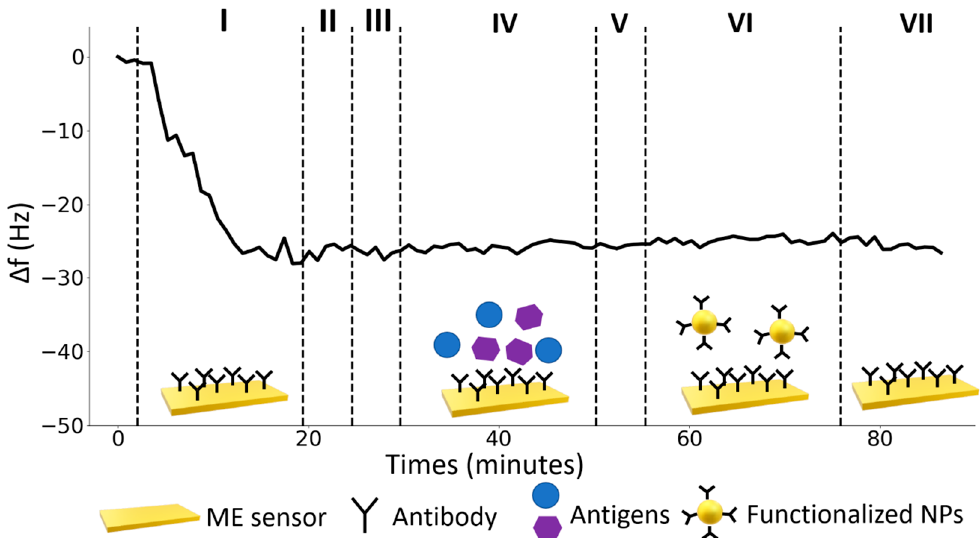
Figure 7. Sensor specificity. ME sensor responses to a mixed solution of rabbit IgG produced in sheep and mouse IgG produced in goat. The black line represents the response of the sensing ribbon in each of the following steps: (I) functionalization with a solution of 25 μ g ∙ mL − 1 of UV-activated antibodies, (II) rinse with MilliQ water, (III) flowing of bovine serum albumin solution (50 μ g ∙ mL − 1 ), (IV) flowing of Rabbit IgG produced in sheep and Mouse IgG produced in goat solution both at a concentration of 20 μ g mL − 1 , (V) rinse with MilliQ water, (VI) amplification with core-shell NPs (Fe 3 O 4 @Au NPs ) , (VII) rinse with MilliQ water.